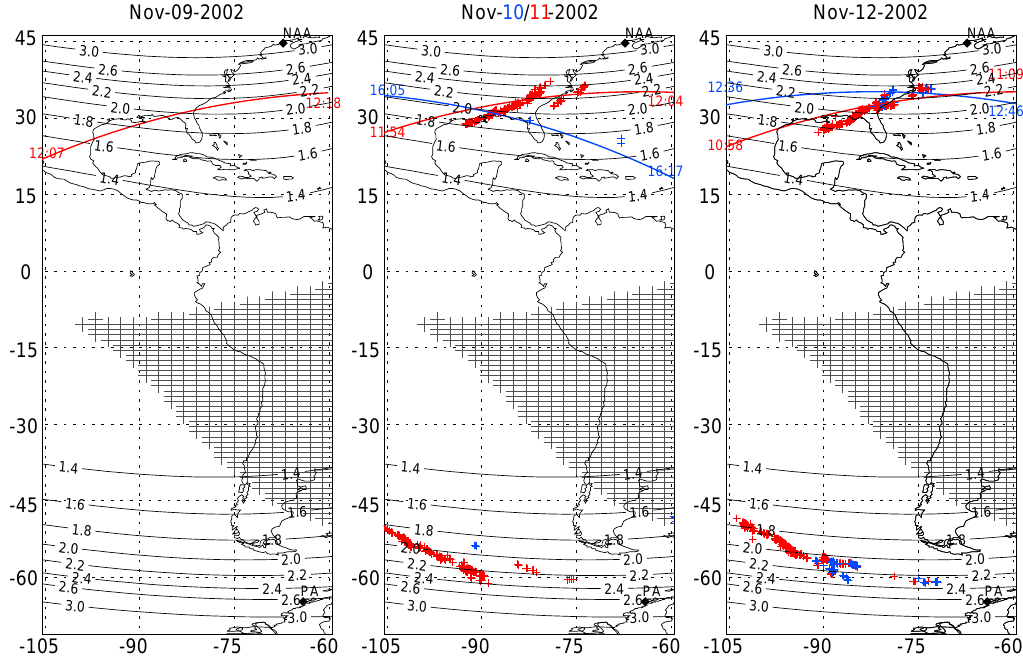
Fig. 5. Lightning discharges detected by the LIS aboard TRMM are shown as a red/blue crosses, together with respective TRMM trajectories indicated by solid red/blue curves. The crosses in the South indicate magnetically conjugate points (using IGRF 2000 geomagnetic field model) of the northern lightning flashes. Note that, for L ∼ 1.8, the 150 keV electrons need ∼ 20 minutes to drift from a longitude of conjugate flashes at − 100 ◦ to their loss from radiation belts at − 70 ◦ .